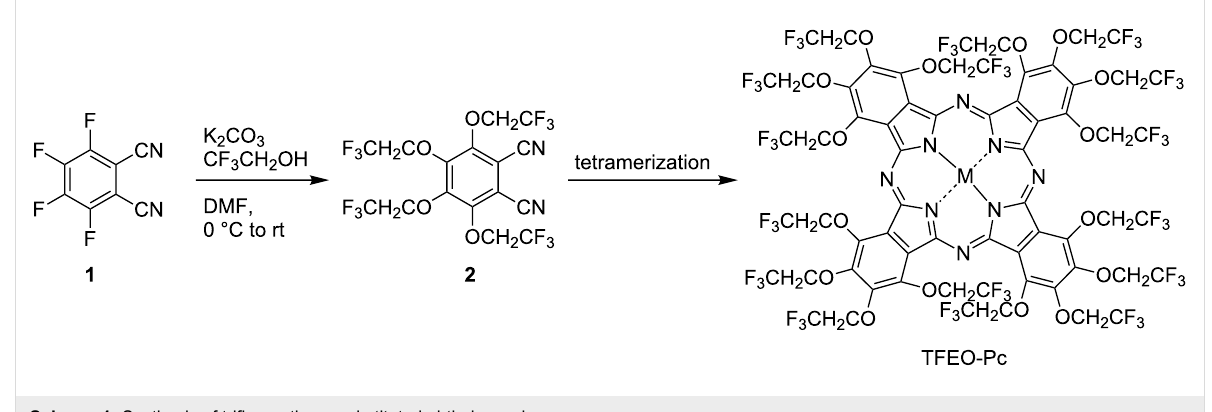
Scheme 1: Synthesis of trifluoroethoxy-substituted